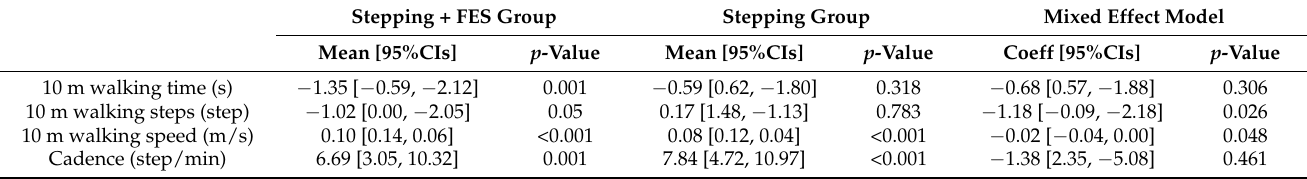
Table 2. Changes in 10MWT after the